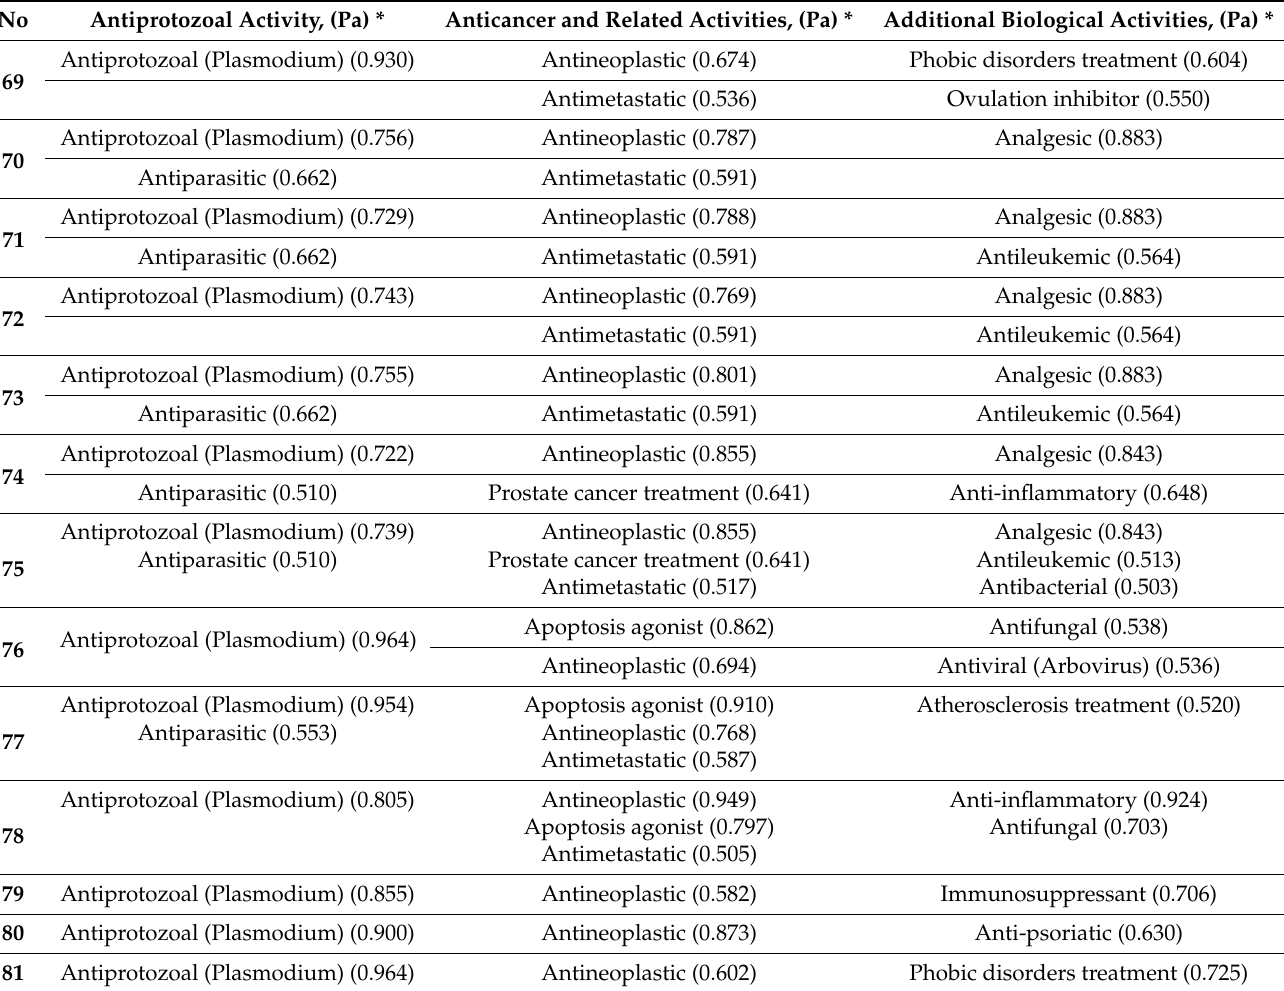
Table 5. Biological activity of the natural polycyclic peroxides derived from